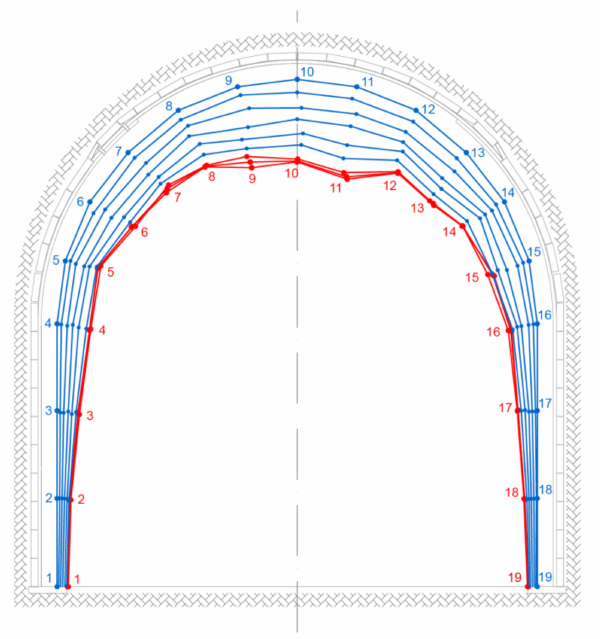
Figure 12. Topology of the gate road support over time, blue color-observed and red color-forecasted